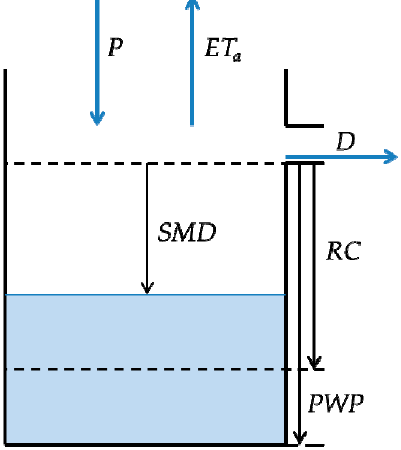
Figure 4. Structure of the simple bucket model (after [39]).